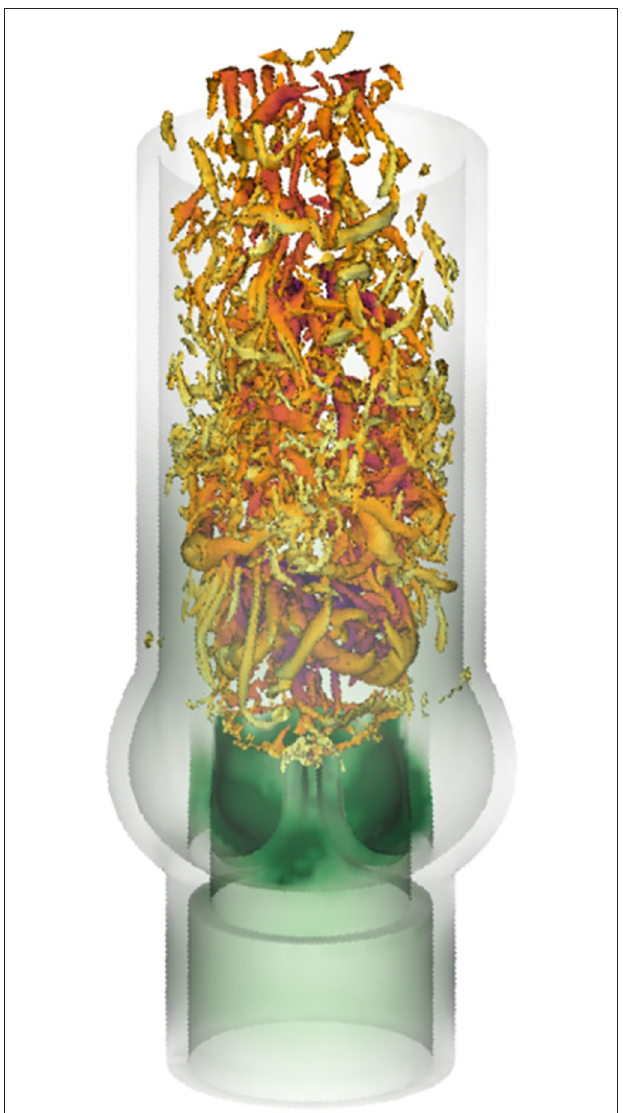
FIGURE 8 | Vortical structures at t = 0.24s visualized by isosurfaces of the λ 2 -criterion by Jeong and Hussain